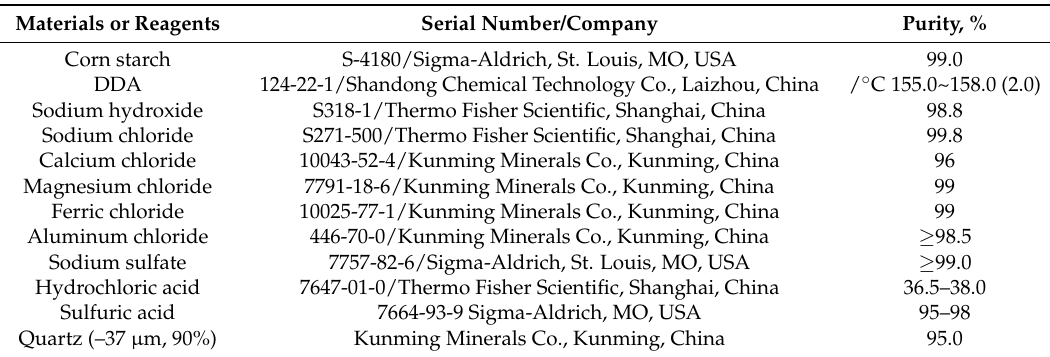
Table 2. The materials and reagents used in this